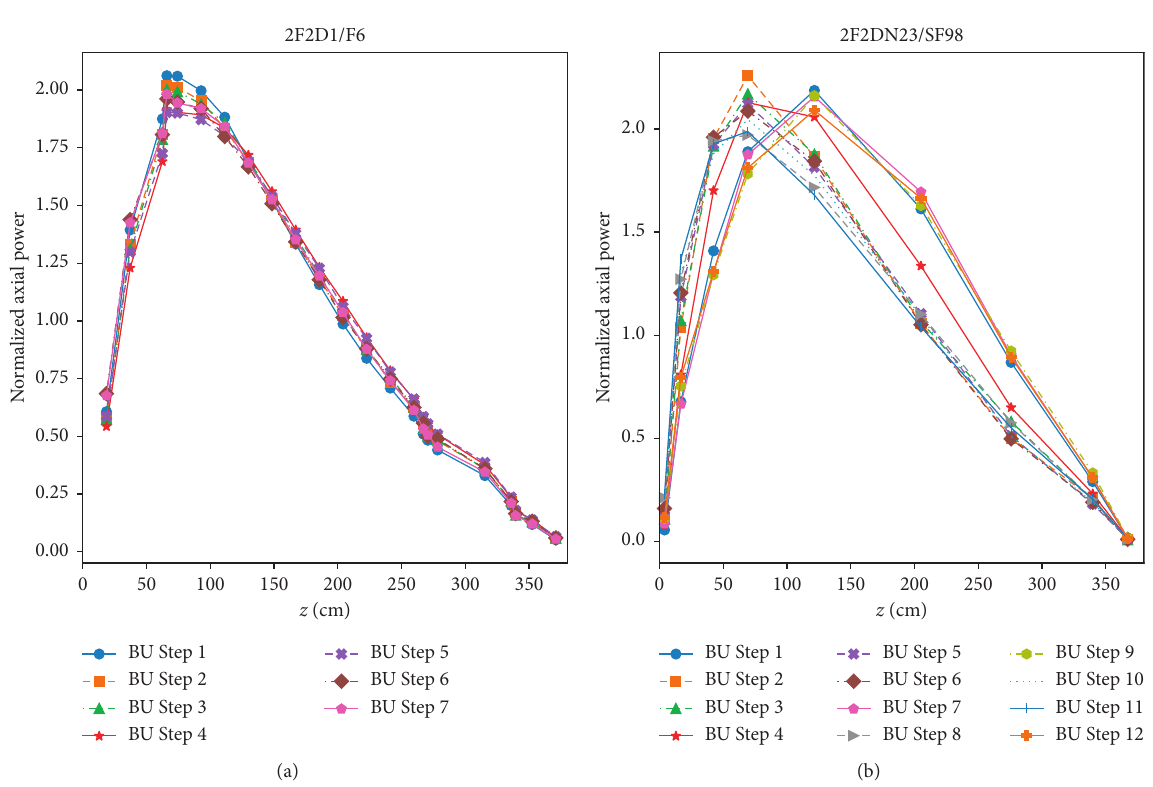
with burnup for 2F2DN23 (a) and 2F2D1 (b). ∞